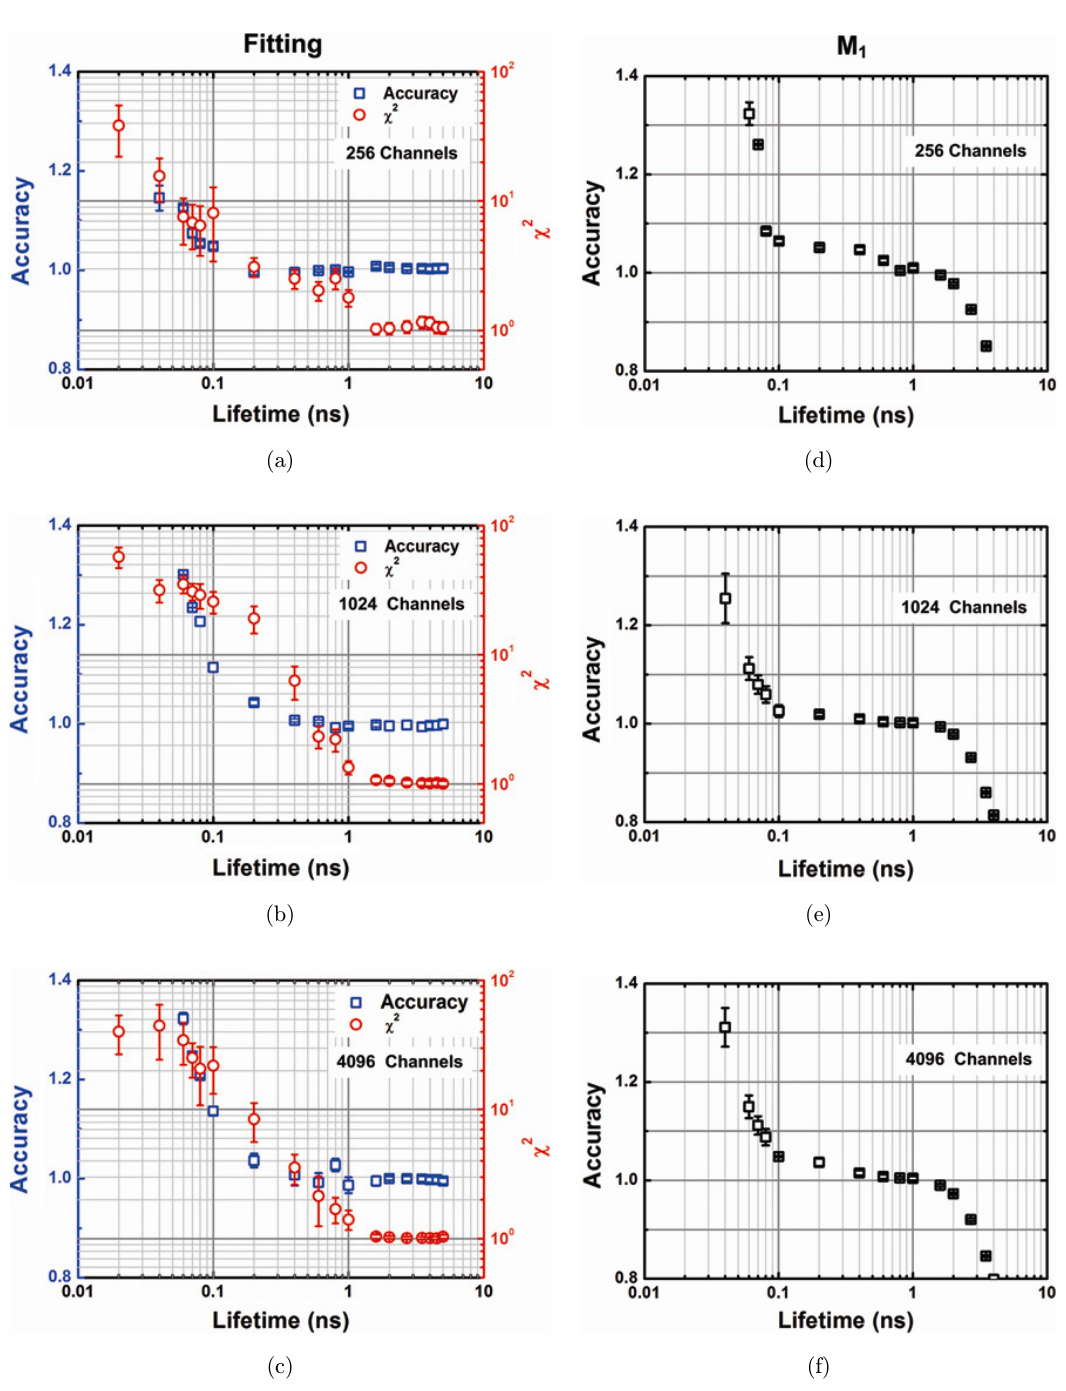
Fig. 2. The accuracy and precision of lifetime measurement using the Fitting and the M 1 methods. The signal N ¼ 10 5 , and the data are from 1000 repeated